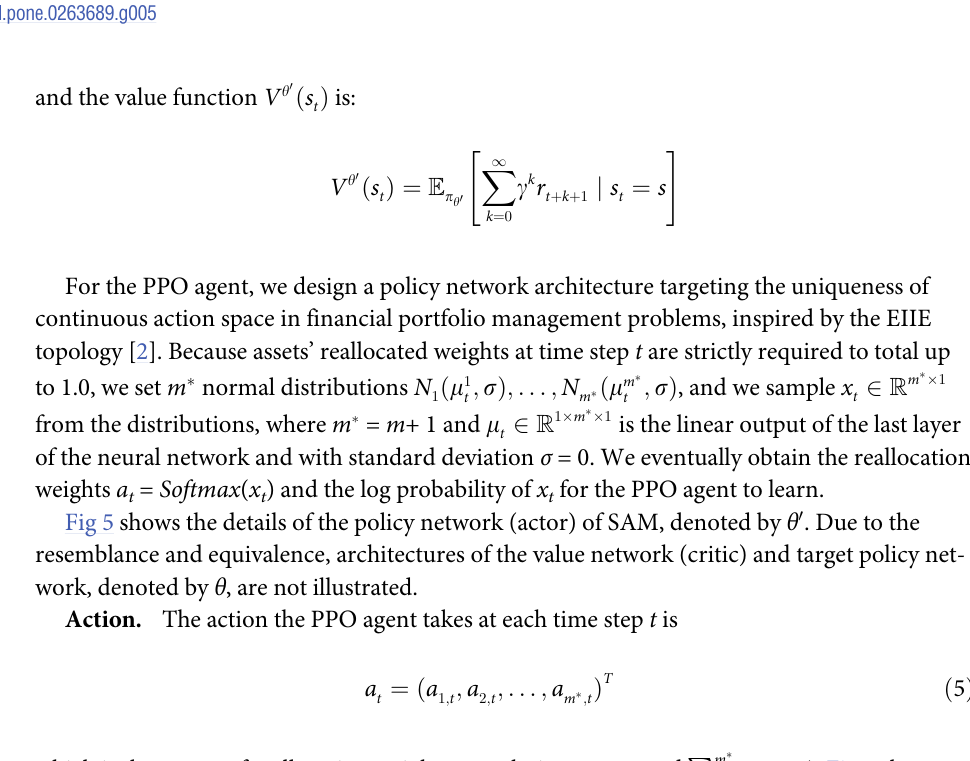
is the input of the network. f is the number of features, m � is t 2 R m � � 1 are sampled from the normal t